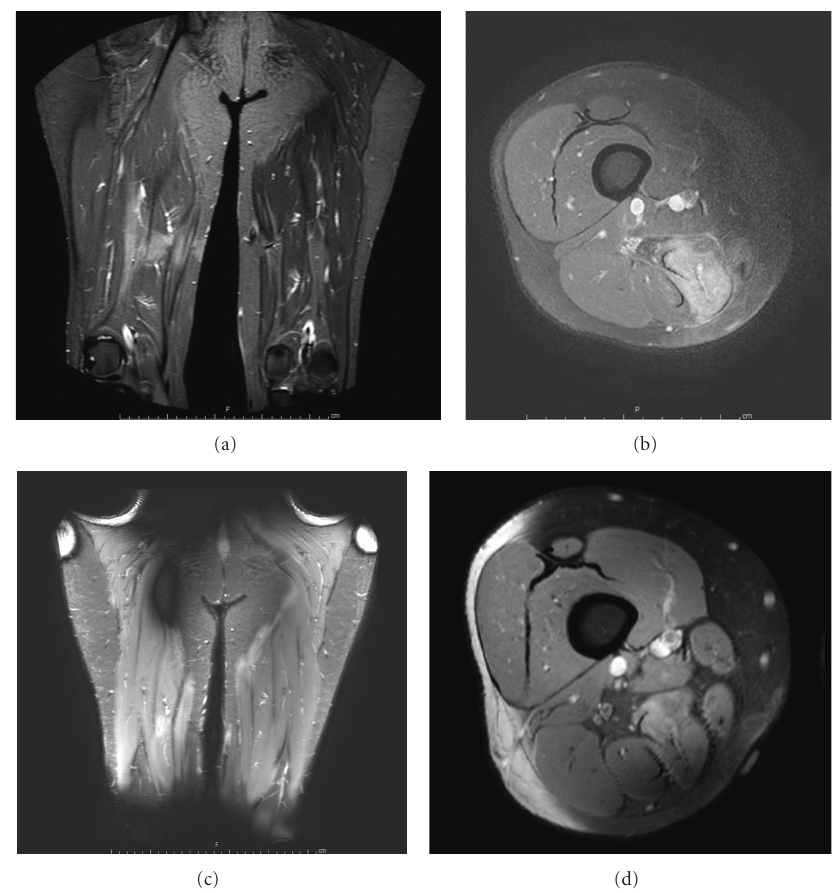
Figure 1: (a) and (b) Initial MRI of the lower extremities demonstrates edema in the right semimembranosis and semitendinosis muscles with abnormal enhancement in the distal sciatic and common peroneal nerves. (c) and (d) Delayed MRI of the lower extremities demonstrates near resolution of edema in the muscle and normalization of the nerves without abnormal